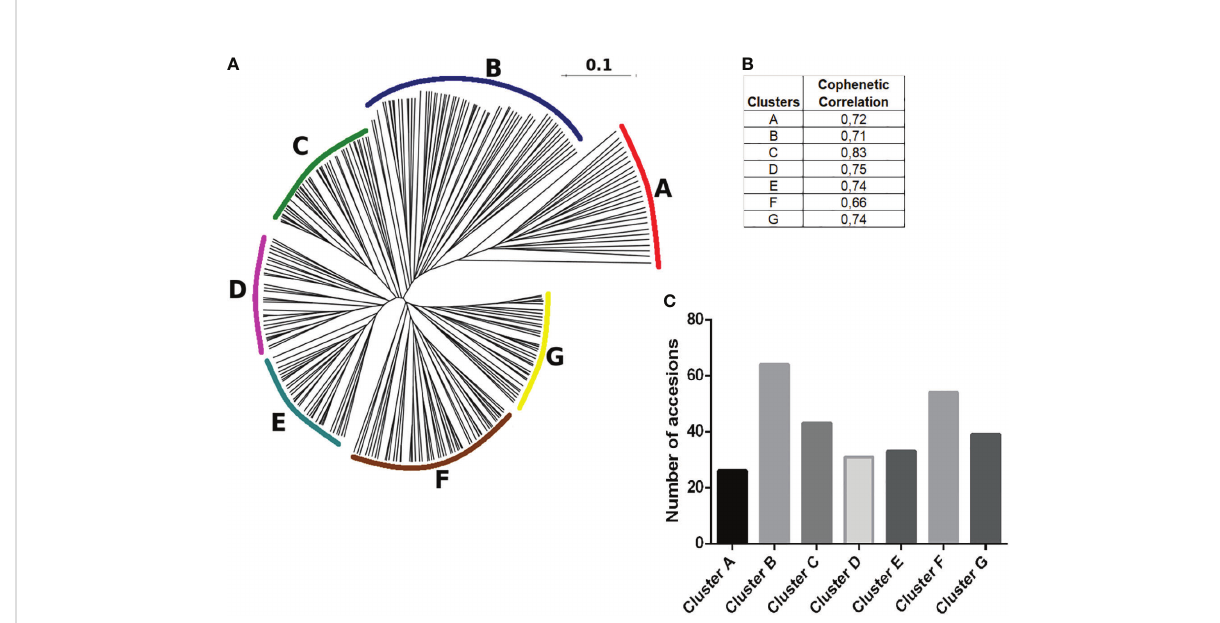
FIGURE 6 Hierarchical clustering of varieties. (A) The DendroUPGMA server was used to calculate the Dice similarity matrix coef fi cients between accessions using the UPGMA method to calculate an agglomerative hierarchical clustering representation of mean genetic relatedness within each species represented in a dendrogram with regard to allelic pro fi les contained within the 22 SSRs. (B) Cophenetic correlation coef fi cients of UPGMA clusters, values close to 1 represent the usefulness of the clustering method, and values between 0.6 and 1 are those with the highest correlation. (C) Total number of accessions distributed in the different genetic subgroups determined in this